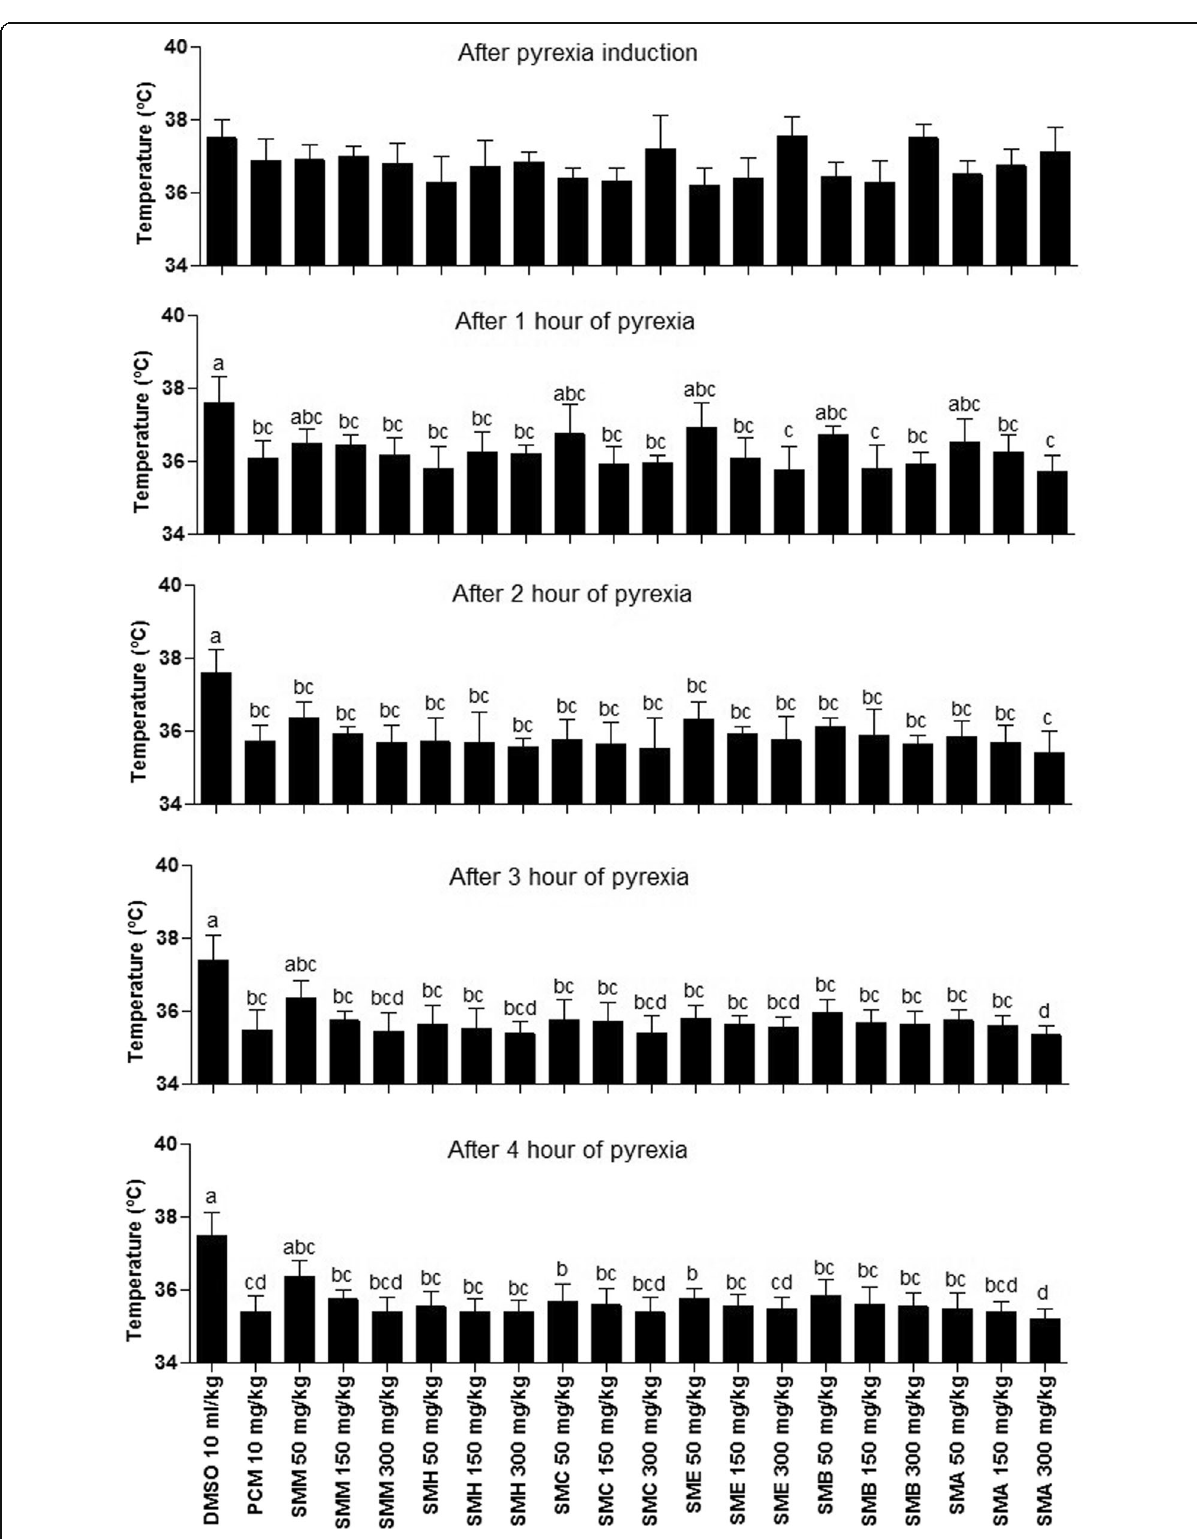
Fig. 6 Antipyretic potential of different extract/fractions of S. mukorossi in rat. Each bar represents as Mean ± SD (n = 3). Superscript ( a-d ) indicate significance at P < 0.01. SMM, S. mukorossi methanol extract of stem bark; SMH, n-hexane fraction of SMM; SMC, chloroform fraction of SMM; SME, ethyl acetate fraction of SMM; SMA, soluble residual aqueous fraction of